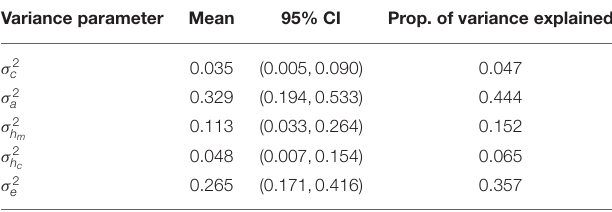
TABLE 3 | Posterior mean, 95% confidence interval (CI) for variance parameters, and the proportion of variation explained by each variance component for the case study estimating mitochondrial haplotype effects on milk yield in cattle. Variance parameter